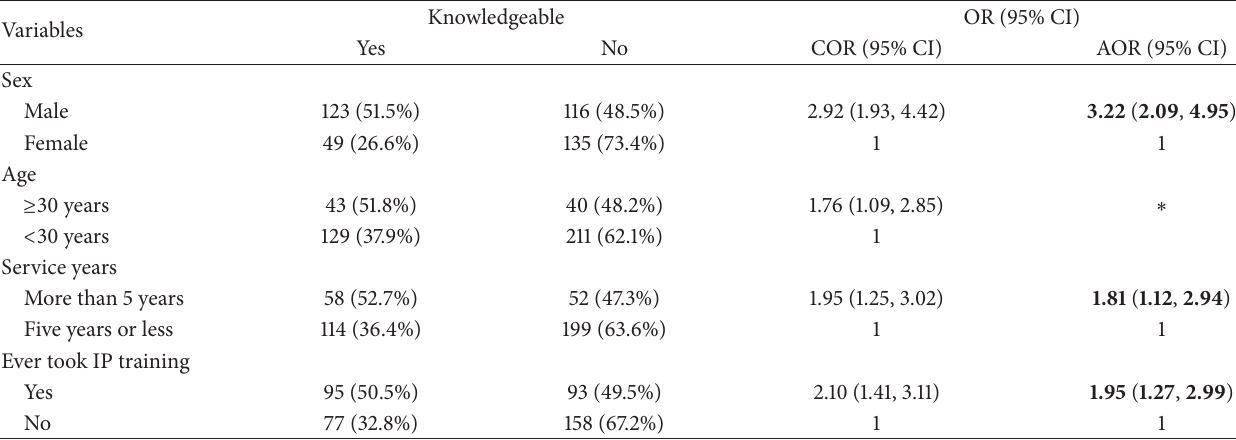
Table 2: Multivariate logistic regression of factors associated with knowledge about surgical site infection prevention activities among nurses working in Gondar and Debre Markos Referral Hospitals, Northwest Ethiopia, 2015 ( 𝑛 = 423 ).